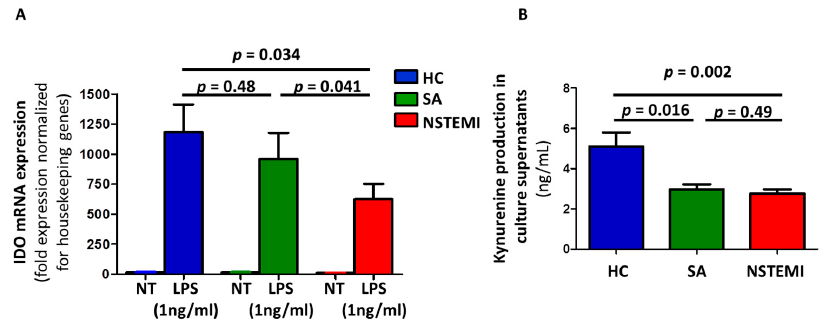
Figure 2. Indoleamine 2,3-dioxygenase (IDO) expression and activity in cultured mMDDCs. Monocytes from 18 NSTEMI, 16 SA and 16 HC were differentiated and activated in vitro to obtain mMDDCs (as described in Figure 1 and Figure S1). ( A ) Stimulation with lipopolysaccharide (LPS) induced the expression of IDO mRNA (assessed by real-time quantitative polymerase chain reaction (RT-qPCR)) in mMDDCs in all three groups of study. Notably, LPS-maturated MDDCs from NSTEMI patients showed lower expression of IDO mRNA compared with SA and HC ( p for trend < 0.001). Data were normalized to β -2microglobulin or GAPDH as housekeeping genes and were expressed as mRNA fold expression using the formula 2- ΔΔ Ct, where Ct is the threshold cycle. NT = untreated MDDC; LPS = LPS-maturated MDDCs. ( B ) Supernatants of mMDDCs were tested by ELISA for production of the tryptophan catabolite kynurenine, as an index of IDO activity ( p for trend = 0.004). Data are expressed as means ± SEM.